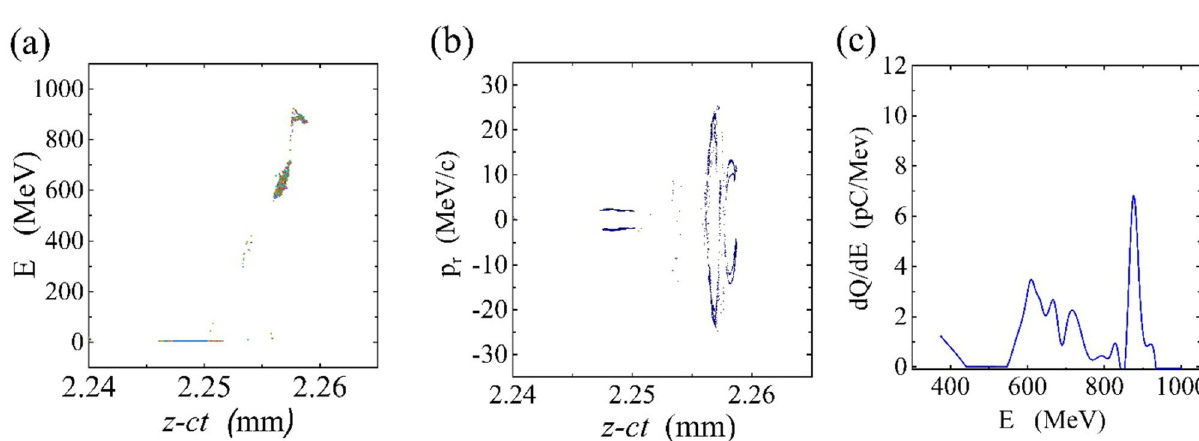
Figure 4. The phase space of self-trapped electrons for a hybrid accelerator considering a non-evolving electron bunch after 2.3 mm propagation. Energy gain from the wake ( a ), Transverse momentum vs. propagation distance ( b ), and electron energy spectrum ( c